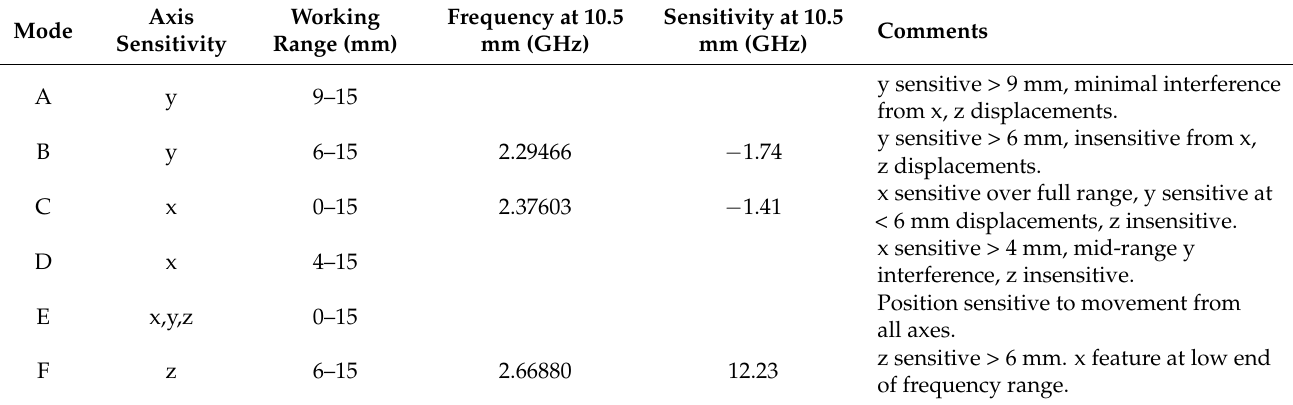
Figure 6. Polynomial fits to the 3 most suitable bands for determining filter displacement indicate x, y, z displacement sensitivities of − 1.41 MHz/mm, − 1.74 MHz/mm and 12.23 MHz/mm, respec- tively. Table 2. Summary of results showing sensitivity of features seen in the S 21 trace due to filter dis- placement.